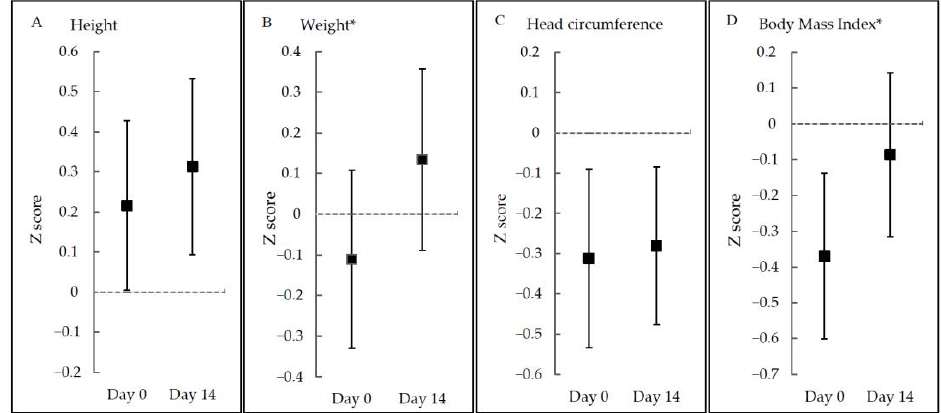
Figure 2. Z-scores at Day 0 and Day 14 according to growth parameters. * p < 0.05.